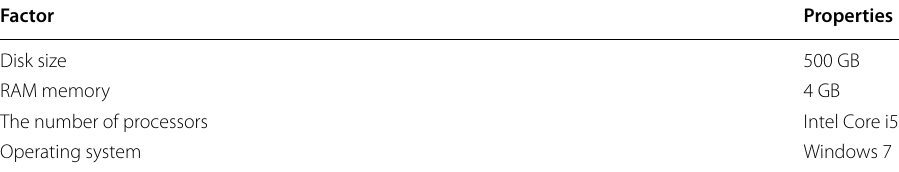
Table 5 Factors and specifications of the simulation